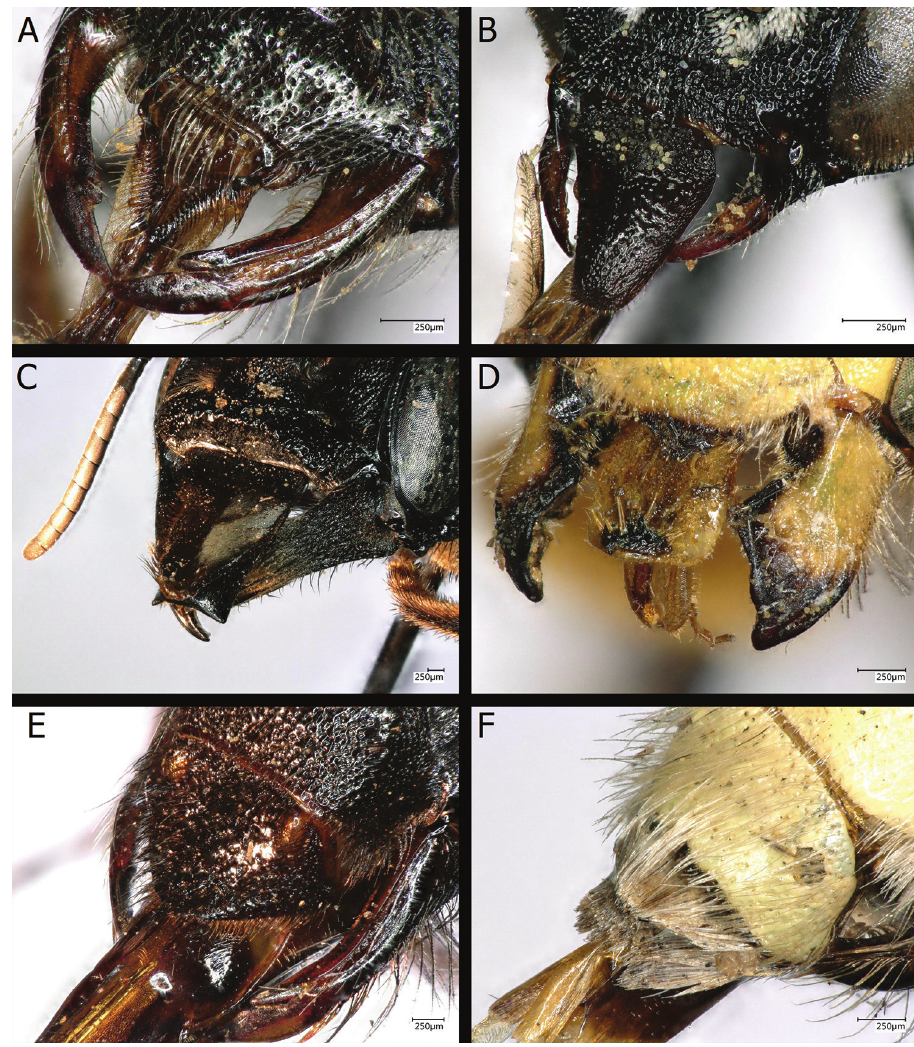
Figure 1. Labrum form diversity in bees. A Halictus ligatus Say 1837 female (NPIC:87530) B Holco- pasites insoletus (Linsley, 1942) male (NPIC:BBSL211611) C Megachile sculpturalis Smith 1853 female (NPIC:BBSL1030971) D Trachusa larreae (Cockerell, 1897) female (NPIC:94880) E Habropoda laboriosa (Fabricius, 1804) female (NPIC:BBSL253733) F Anthophora abrupta Say, 1838 male (NPIC:BBSL231004). Scale bars indicate 250µm for each image